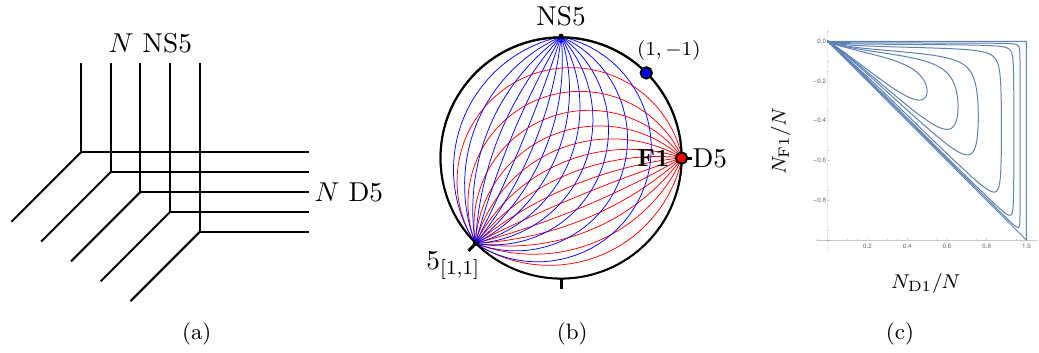
Figure 5 . Left: brane web for the gauge theory (2.30). Center: T N supergravity solution on the disc, with the 5-brane poles and some of the string embeddings. Along the red/blue curves the D3-brane has constant F1/D1 charge. Right: ( N D1 ; N F1 ) curves, from outer to inner for (cid:8) (cid:9) Im( w ) 2 10 (cid:0) 6 ; 1 ; 1 ; 1 ; 1 . The Im( w ) = 10 (cid:0) 6 curve follows the boundary of the disc in (cid:12)gure 5(b). 10 5 2 The F1/D1 charges identify the vertical/horizontal coordinate of the face in which the D3-brane is located in the brane